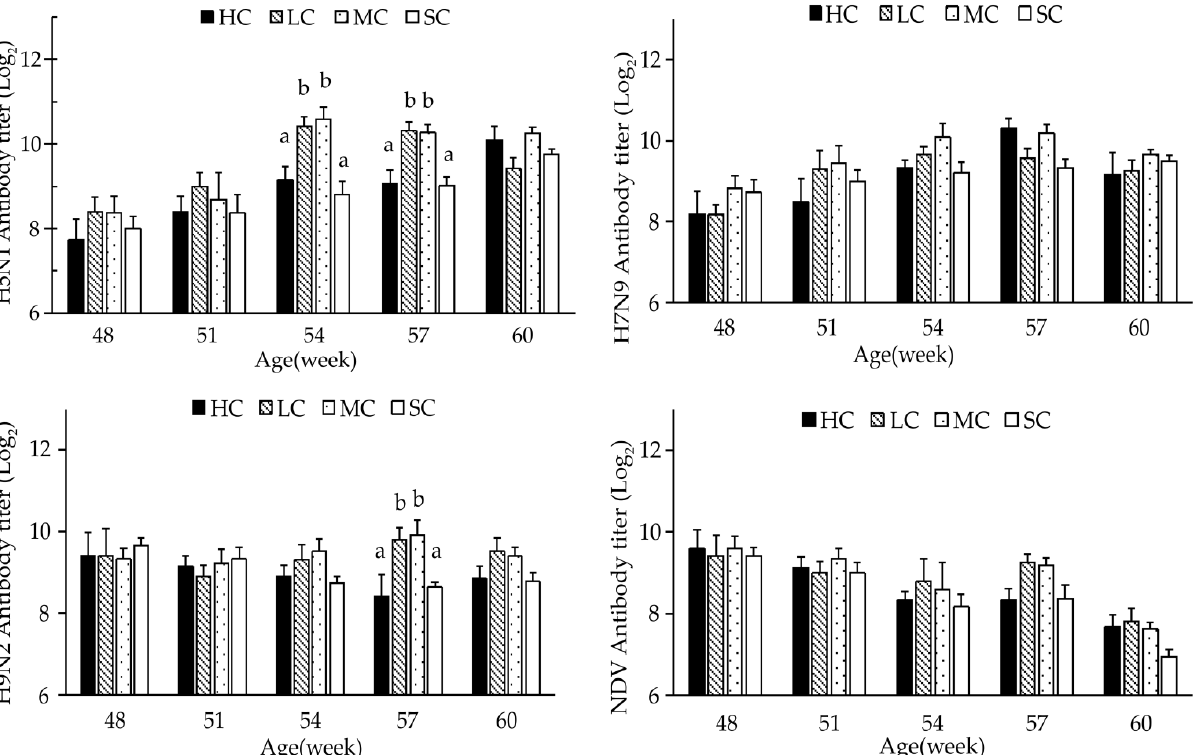
Figure 2. Antibody titre of birds reared in different cage size groups from 46 to 60 weeks of age. HC, huge cage; LC, large cage; MC, medium cage; SC, small cage. a,b Means within a week with different letters are significantly different ( p < 0.05).